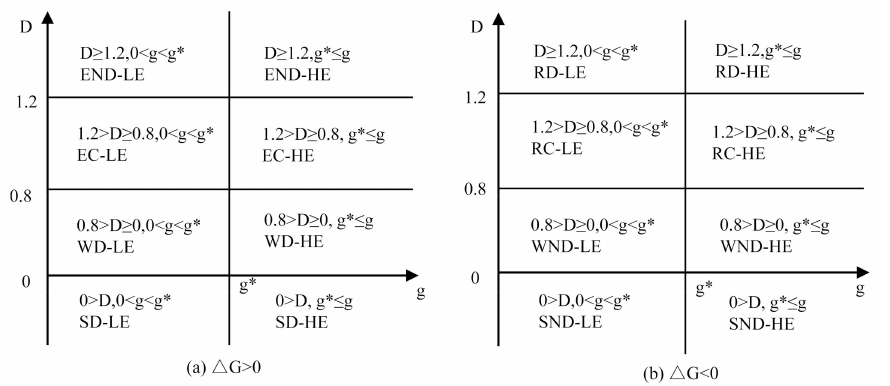
Figure 2. The divisions of decoupling status of the two-dimensional decoupling model. ( a ) ∆ G > 0, ( b ) ∆ G < 0 (g* means the threshold value of per capita